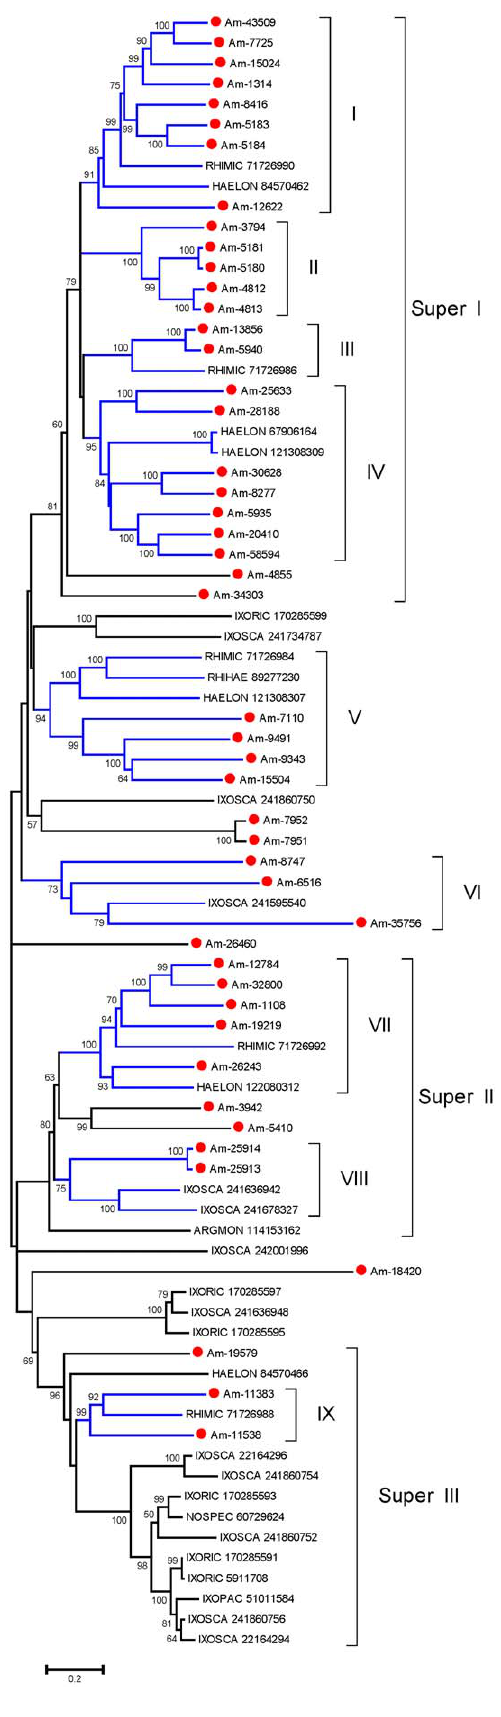
Figure 5. Phylogram of the tick salivary metalloproteases of the reprolysin family. The bootstrapped phylogram (1,000 iterations) was obtained from the alignment of deducted Amblyomma maculatum proteins with homologs found in the non-redundant protein database of the NCBI. The Am. maculatum protein names start with Am- and are recognized by a red circle marker; the remaining proteins are named by the first three letters of the genus name followed by the first three letters of the species name followed by their NCBI gi| accession number. The number at the nodes indicates the bootstrap support, and the bar at the bottom indicates 20% amino acid divergence. Clades and superclades with strong bootstrap support are indicated with Roman numerals.